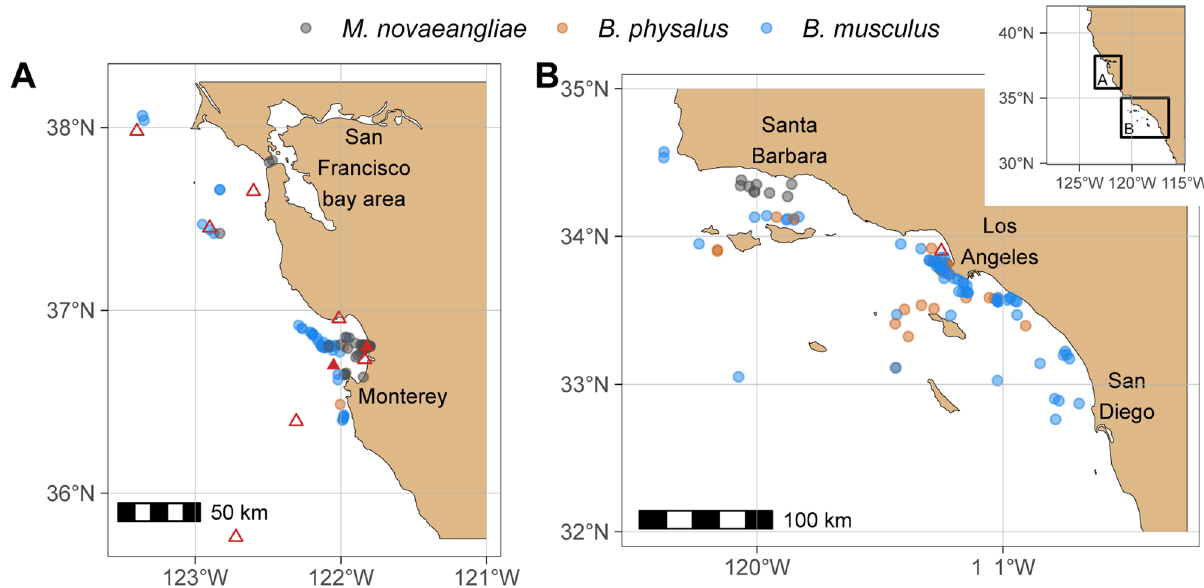
Fig.2|Locationsoftagdeployments,plasticsamplinglocations,andpreydata collection used in this analysis. Filled red triangles represent plastic sampling locations at depth 50 and hollow red triangles represent surface locations 47 . Circle